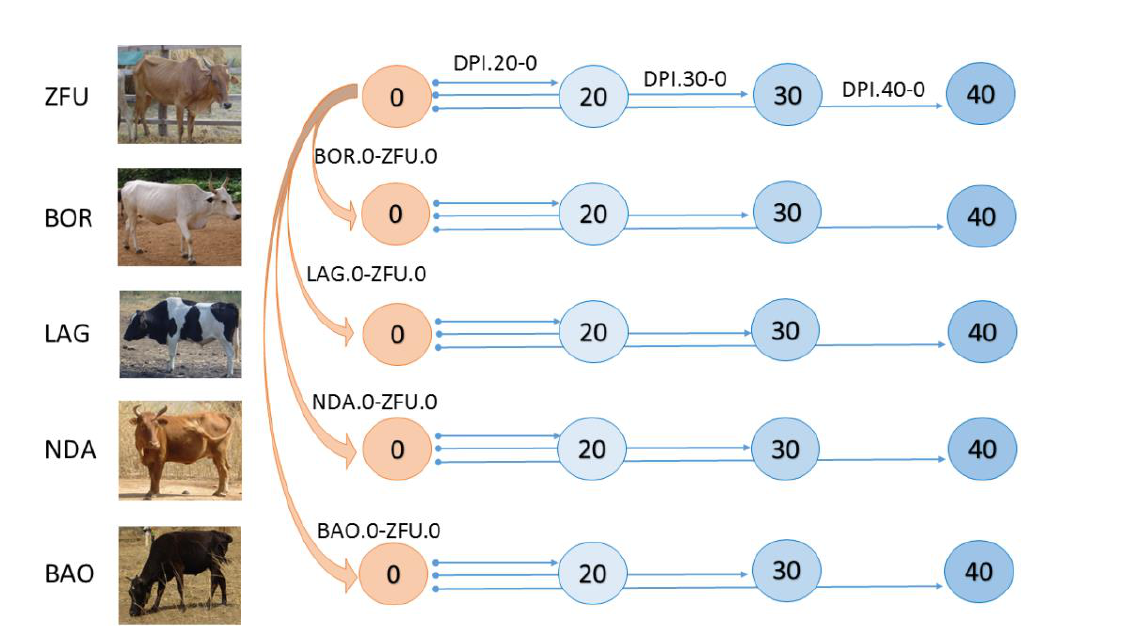
Figure 1 - Description of the contrasts used for the differential gene expression analysis. The numbers in the circles represent the days post-infection of cattle sampling, at DPI.0, DPI.20, DPI.30 and DPI.40. Orange arrows represent the contrasts between the breeds at DPI.0, before infection, named BOR.0-ZFU.0, LAG.0-ZFU.0, NDA.0-ZFU.0, and BAO.0-ZFU.0. The blue arrows represent the within-breed contrasts: for each breed, three contrasts were built with DPI.0 as reference, DPI.20-0, DPI.30-0, and DPI.40-0. ZFU, LAG, and BAO pictures by S. Thévenon; BOR picture by G-K. Dayo; NDA picture by D.